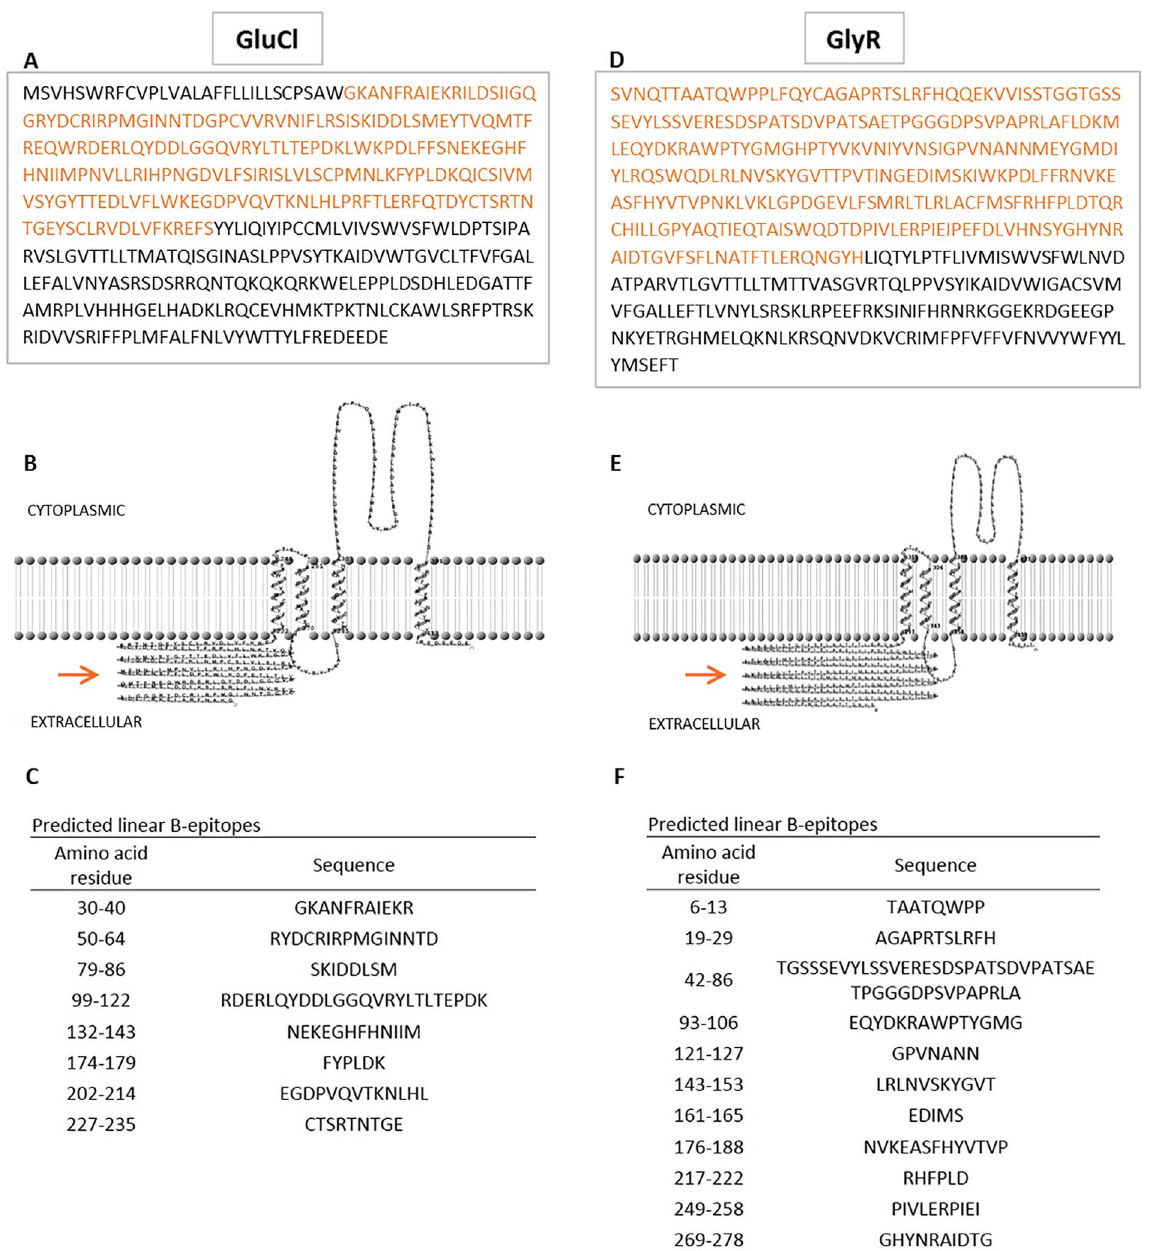
Figure 1. Antigen selection. A. Complete amino acid sequence of a glutamate-gated receptor (GluCl) from R. microplus (GenBank accession no. AHE41097.1). N-terminal domain, highlighted by colored letters, was recombinantly produced in E. coli and evaluated as a vaccine candidate. B. Two-dimensional representation of GluCl. Arrow indicates the extracellular N-terminal domain. C. Linear B-cell epitopes predicted in N-terminal ECD of GluCl. D. Partial amino acid sequence of a glycine-like receptor (GlyR) from R. microplus (GenBank accession no. AHY18971.1). N-terminal domain, highlighted by colored letters, was recombinantly produced in E. coli and evaluated as a vaccine candidate. E. Two-dimensional representation of GlyR. Arrow indicates the extracellular N-terminal domain. F. Linear B-cell epitopes predicted in N-terminal ECD of